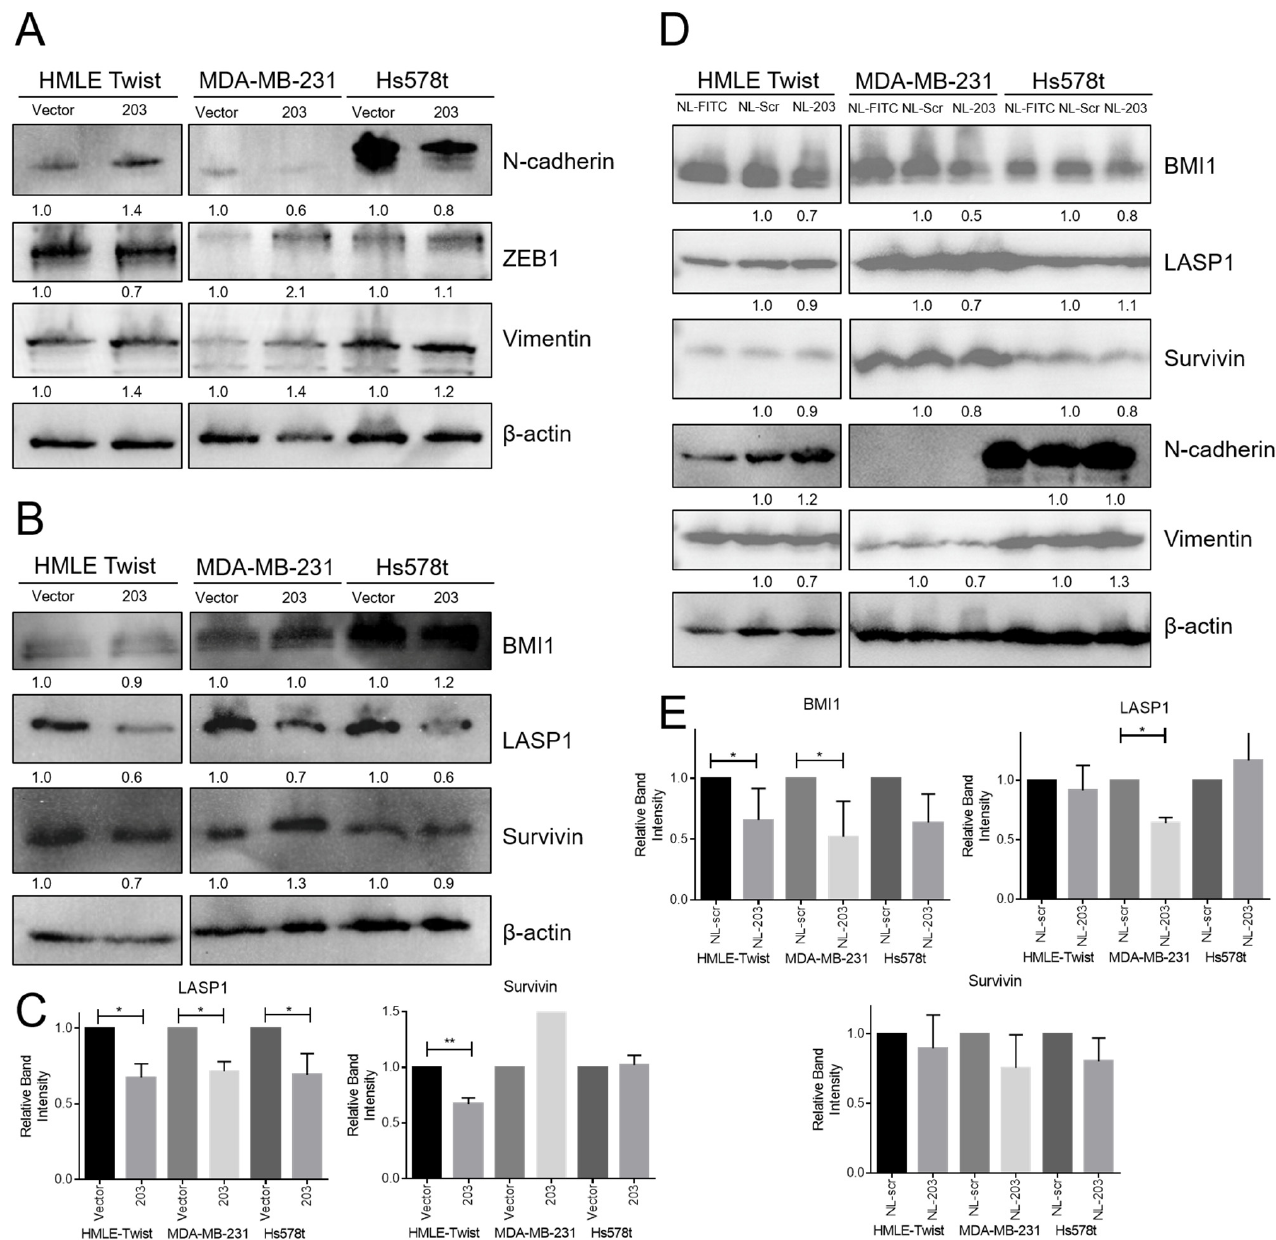
Figure 5. miR-203 induced changes in target proteins and EMT markers. Representative Western blots of indicated proteins from whole cell lysates from ( A – C ) indicated cells with stable miR-203 expression or ( D , E ) indicated cells exposed to microRNA mimic-, scramble control-, or FITC control-loaded nanoliposomes at a concentration of 85 µ M for 48 h prior to protein extraction. ( C , E ) Band intensities from three biological replicates were quantified, normalized to β -actin, and then normalized to each cell line’s vector/scramble control. The average and standard deviation of three replicates are reported. p -value calculated using Student’s two-tailed t -test. * p < 0.05, ** p < 0.01 .